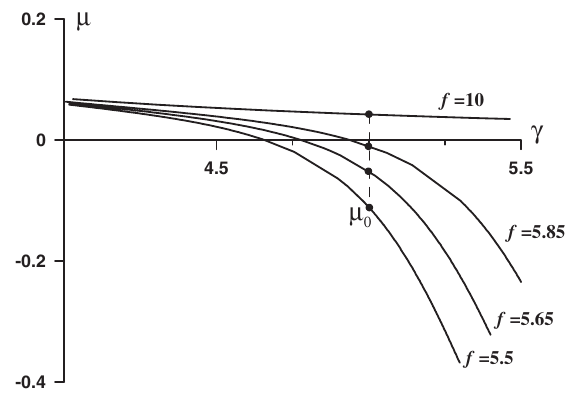
FIG. 12. The bunching parameter (cid:9) as a function of electron ¼ 0 : 1 and different values of guide magnetic energy (cid:3) at (cid:4) w field f : (1) f ¼ 10 ; (2) f ¼ 5 : 85 ; (3) f ¼ 5 : 65 ; (4) f ¼ 5 : 5